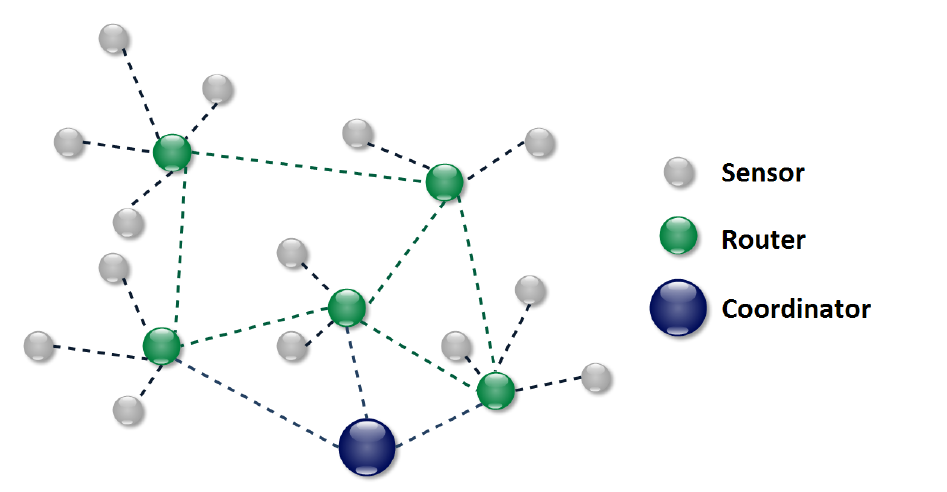
Figure 1. Structure of a